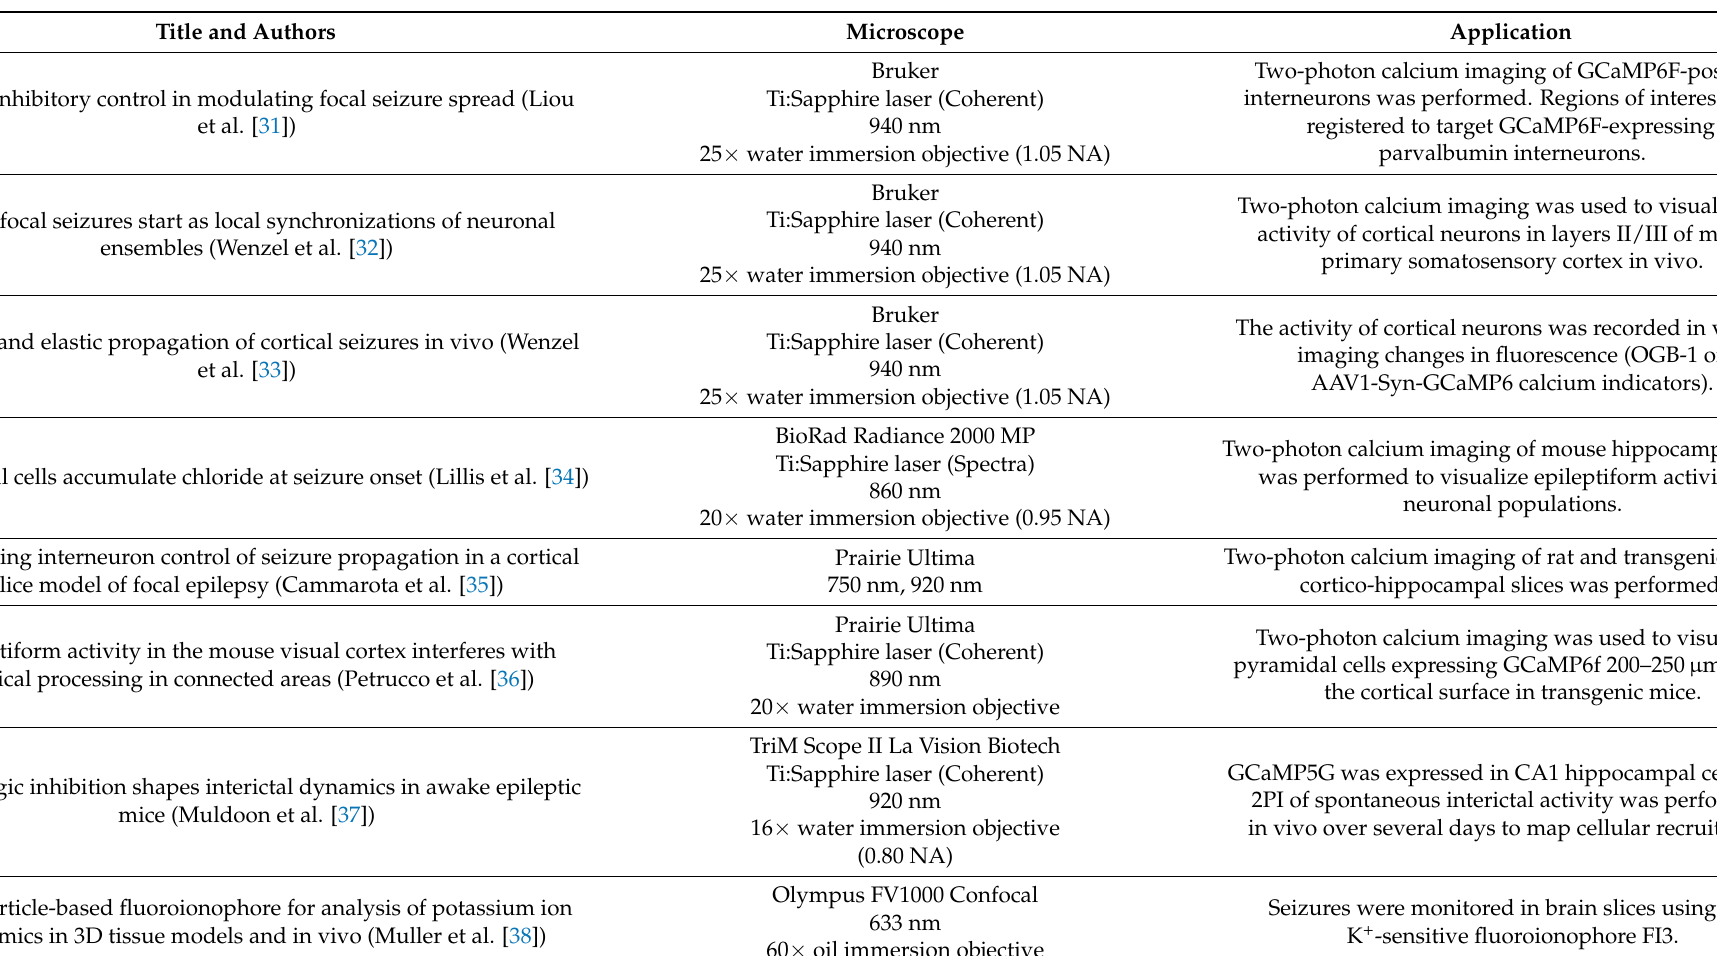
Table 1. Epileptic network propagation—data abstraction table catalogues the type of two-photon microscope used and how two-photon imaging (2PI) was applied in each study within this group of